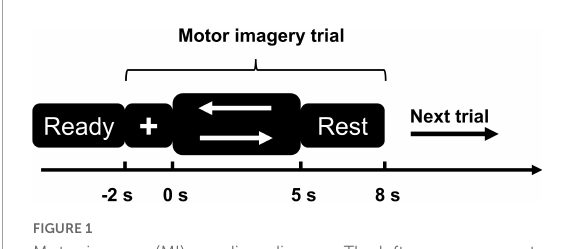
FIGURE1 Motor imagery (MI) paradigm diagram. The left arrow represents the left-side MI task; the right arrow represents the right-side MI